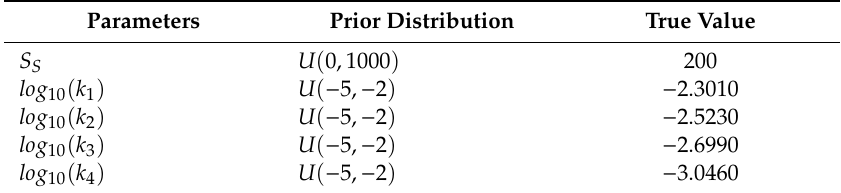
Table 4. The prior distributions and reference true values of the model parameters estimated in Case 2. U stands for the uniform distribution.